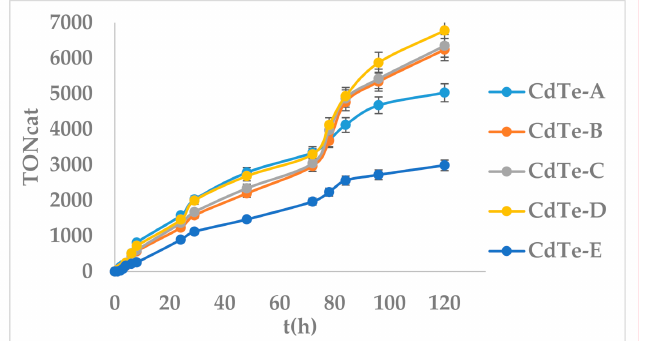
Figure 7. Light-driven hydrogen production from a system containing complex 1 at 5 × 10 − 6 M, ascorbic acid (AscOH) (0.1 M) in DMF: H2O 1:2 at pH 4.5 with differently sized thioglycolic acid (TGA)-coated CdTe quantum dots (QDs) at 40.0 µ M A (blue), B (orange), C (grey), D (yellow), E (light blue) upon irradiation for 120 h at 25 ◦ C and 1 atm.